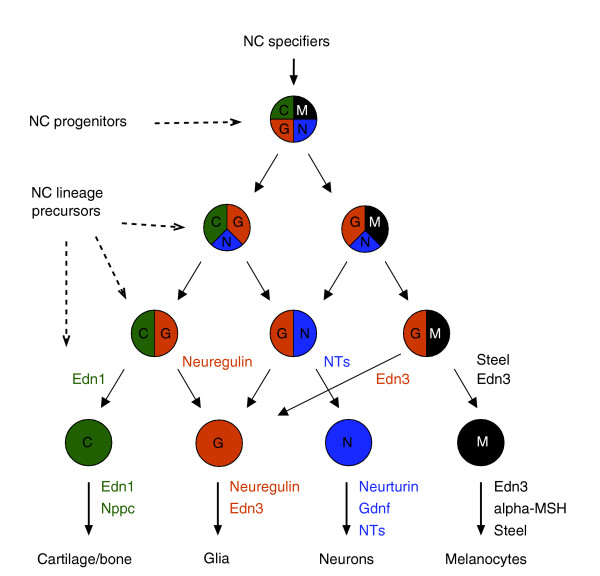
Emerging ligands control the specification of neural crest precursors. The progressive determination of neural crest (NC) precursors into different cell lineages is represented in the scheme with a code of colors. Superimposed on this, the collection of new growth factors appearing first in vertebrates is depicted. The role of each ligand in controlling the specification/survival of each particular neural crest derivative is indicated with a corresponding code of colors. alpha-MSH, alpha-melanocyte-stimulating hormone; End, endothelin; GDNF, glial-derived neurotropic factor; NT, neurotropin; Nppc, natriuretic peptide precursor.